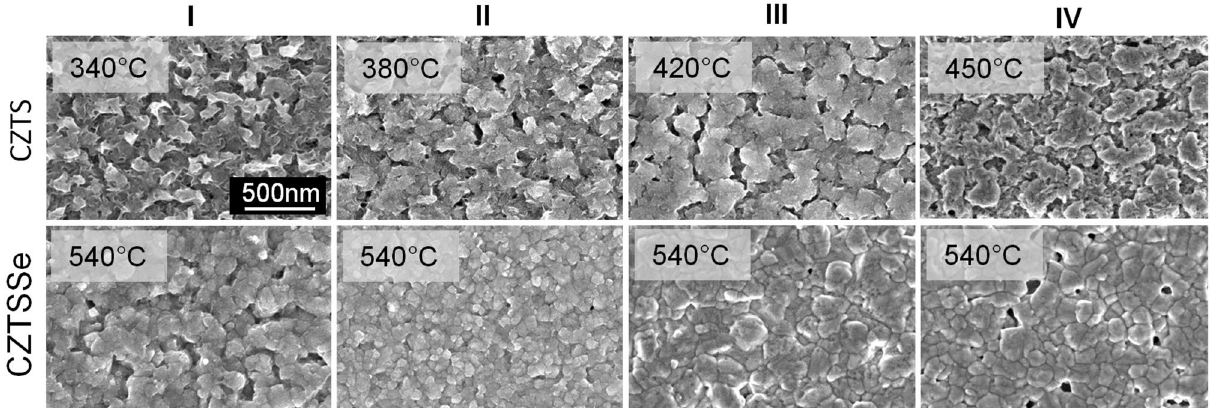
Figure 3. Surface morphology of CZTS and CZTSSe films. Surface morphology SEM images of the as-deposited CZTS film at 340 °C and CZTS films sulfurized at different temperatures (380, 420 and 450 °C) (top view). SEM images of CZTSSe films obtained by annealing each CZTS film at 540 °C in selenium